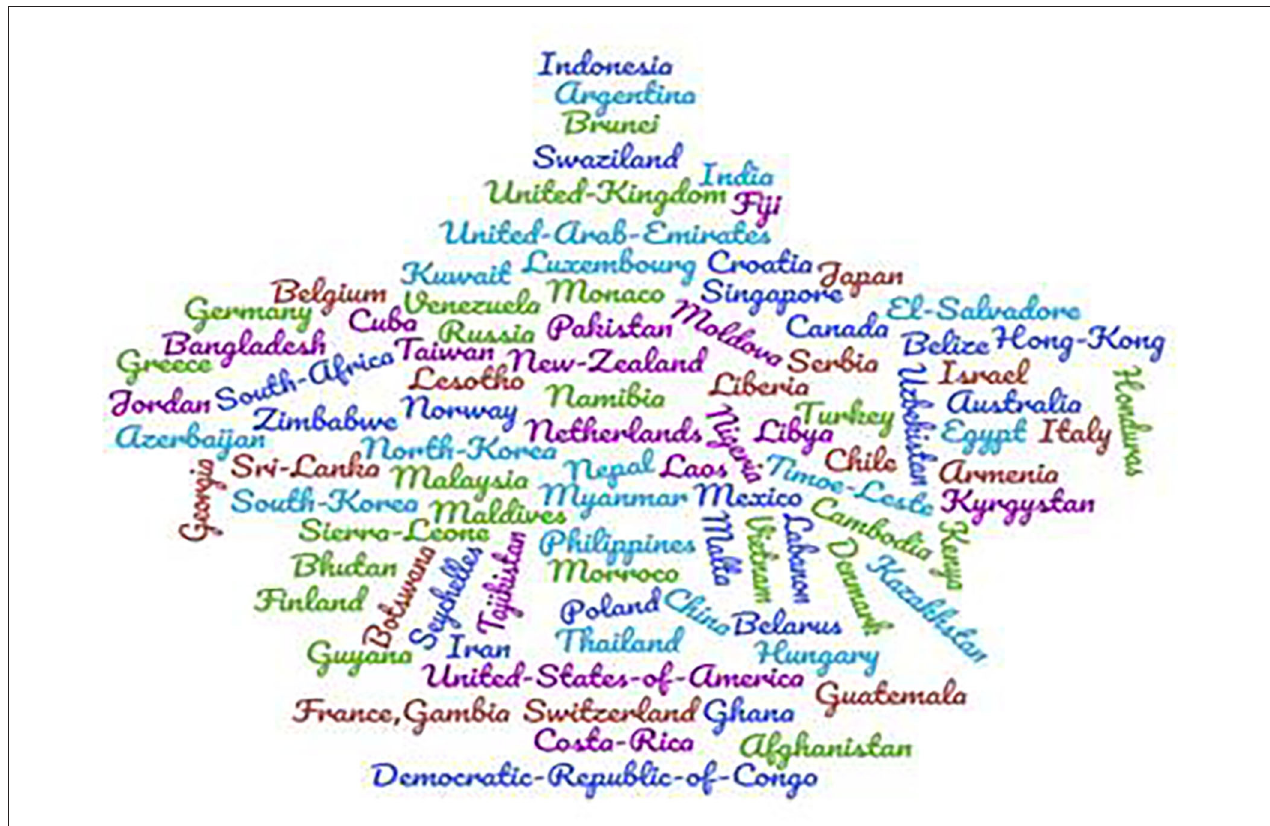
FIGURE 2 | Word cloud showing countries reporting panic buying behavior.